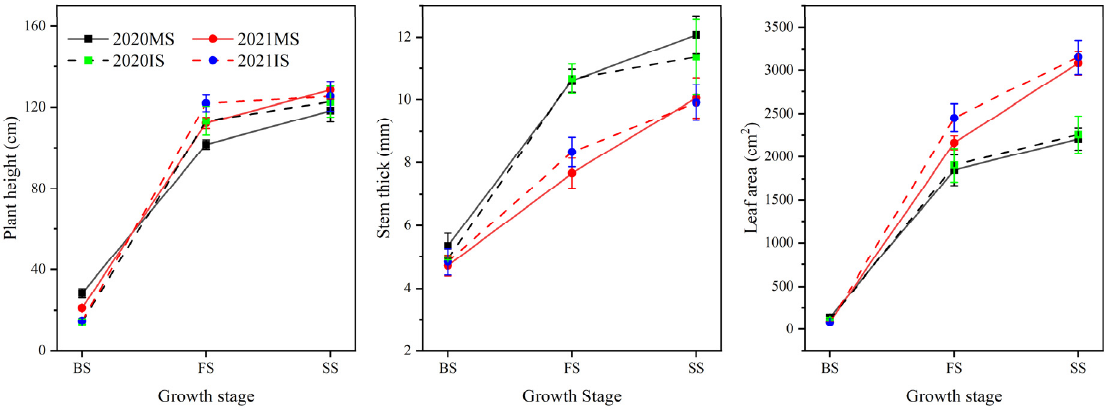
Figure 8. Dynamic changes in the plant height, stem thickness, and leaf area of soybean under different planting patterns in 2020 and 2021. BS: branching stage, FS: flowering-podding stage, and SS: seed filling stage.